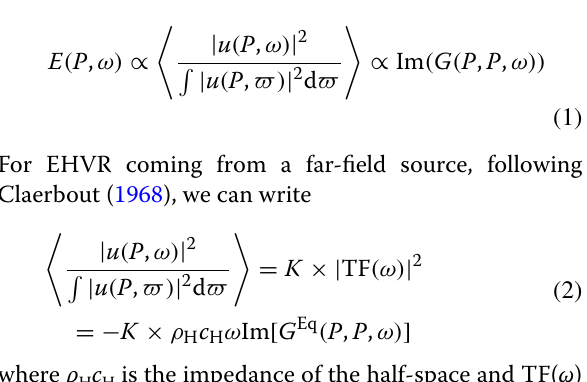
Fig. 3 Measured EHVR at a measurement point EHM012. The averaged EHVR (red), average EHVRs (black). Left: S-wave part, right: coda part immediately after S-wave